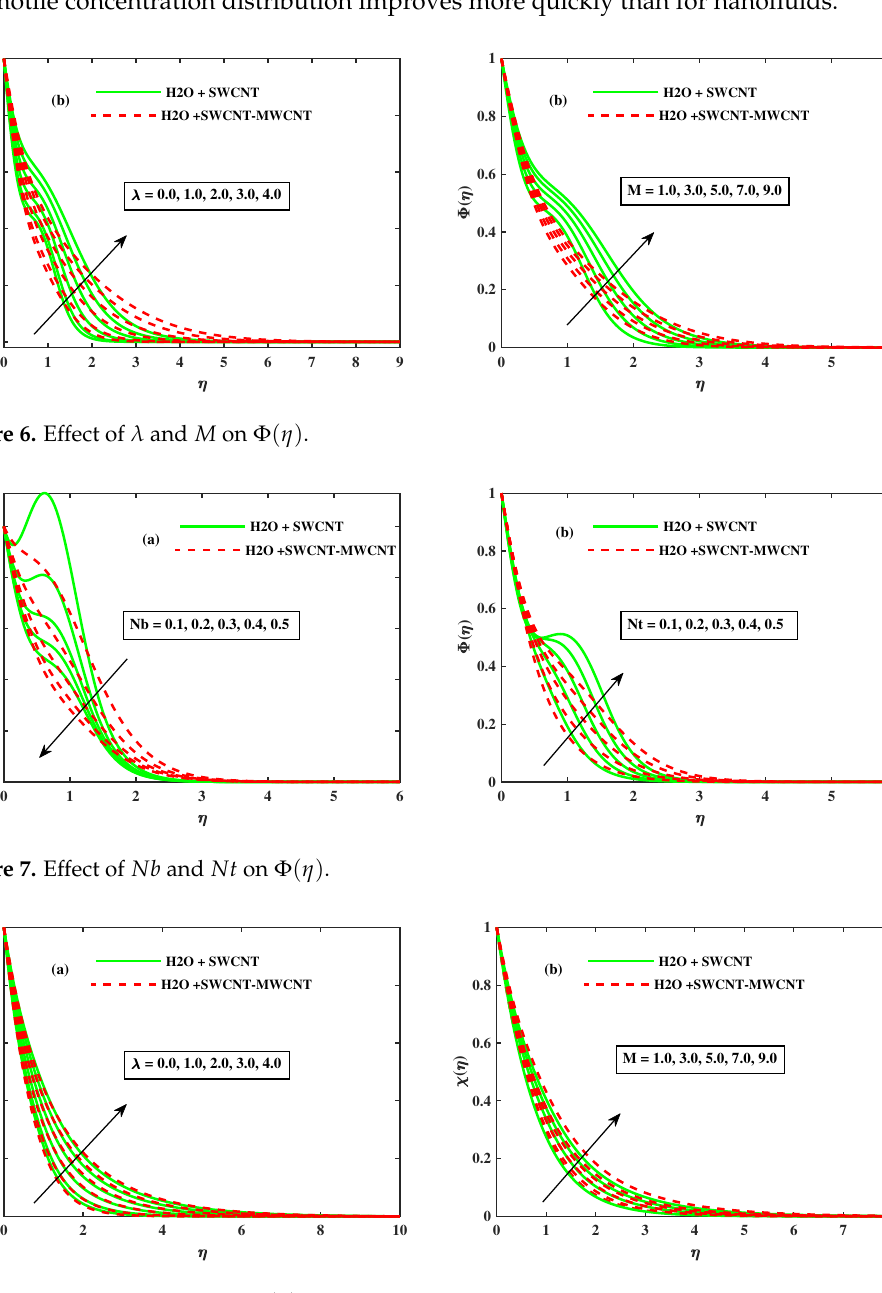
Figure 8. Effect of λ and M on χ ( η ) . Figure 10a,b represents the fluctuation of skin friction coefficients ( C f x · Re x 0.5 , C f y · Re x 0.5 ) with respect to the x , y -direction, respectively, under the influence of the parameters M and λ . It has been discovered that skin friction coefficients rise as λ increases. It is to be noted that the skin friction coefficients is larger in values for hybrid nano fluid than nanofluid. Figure 11a,b demonstrates the effect of Nu x · Re x − 0.5 and Shr x · Re x 0.5 when the parameters λ and M are supplied with different inputs. These numbers endure a significant decrease with λ and M